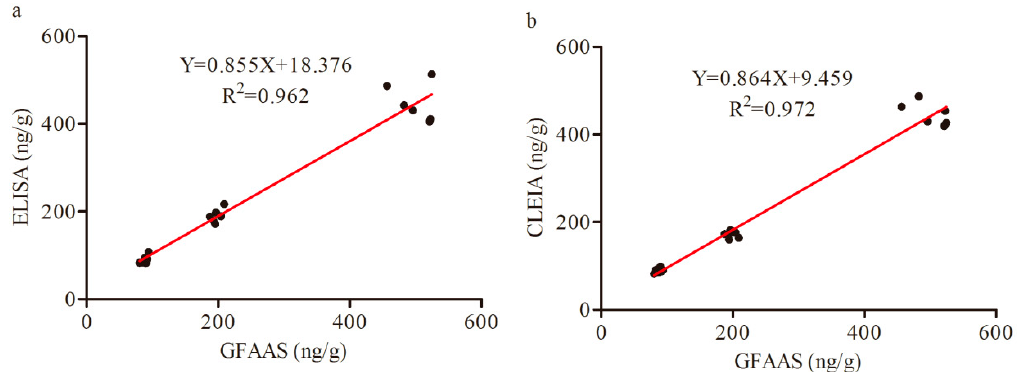
Figure 5. Correlation of ELISA and CLEIA to GFAAS on lead ions analysis.